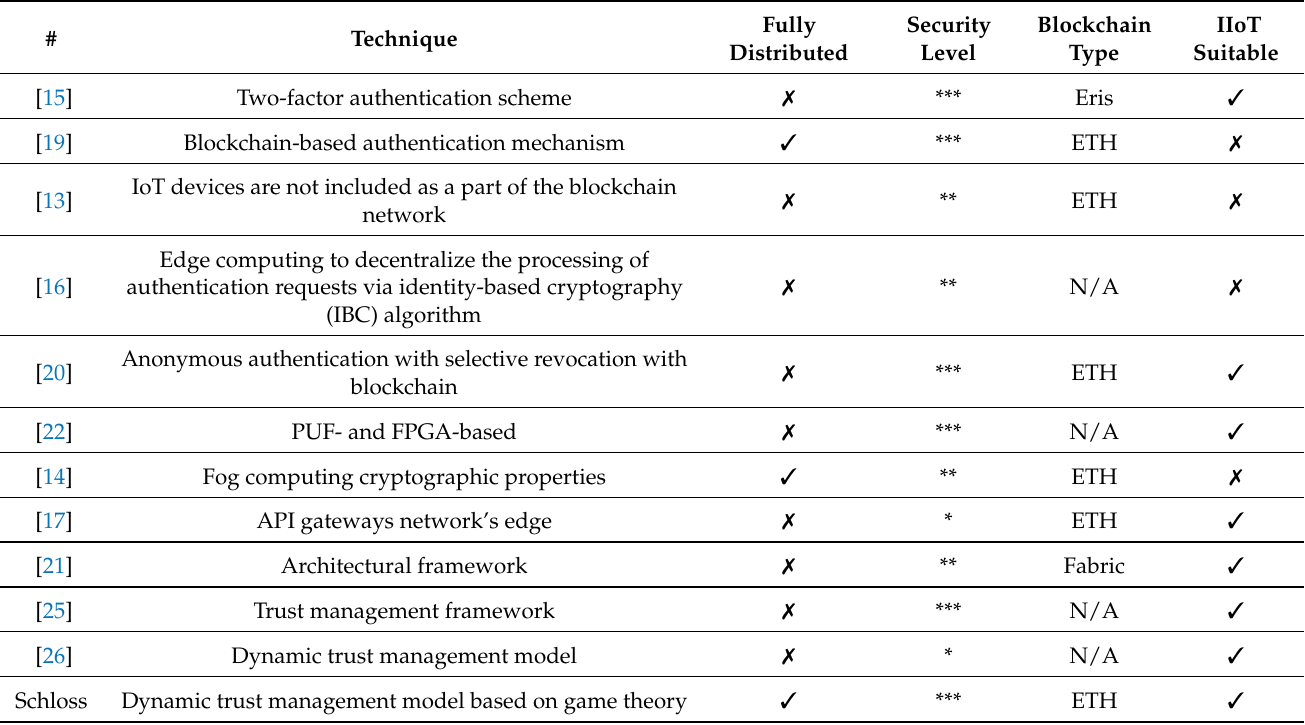
Table 1. Overview of state of the art for secure blockchain